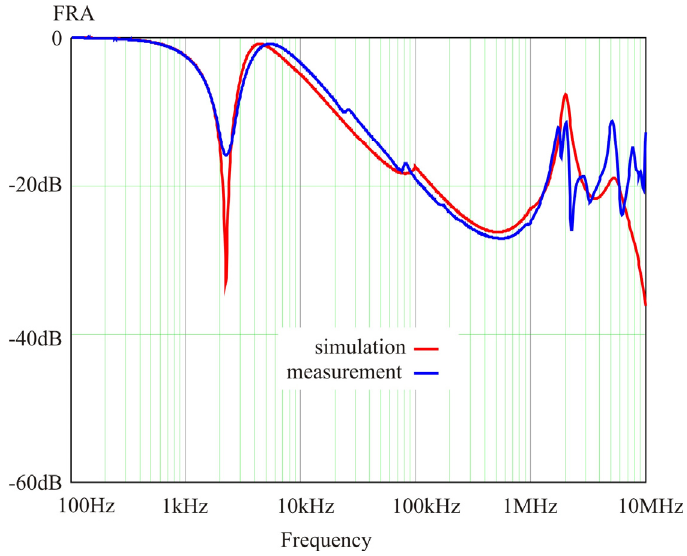
Figure 9. Frequency response of proposed model compared to measurement.